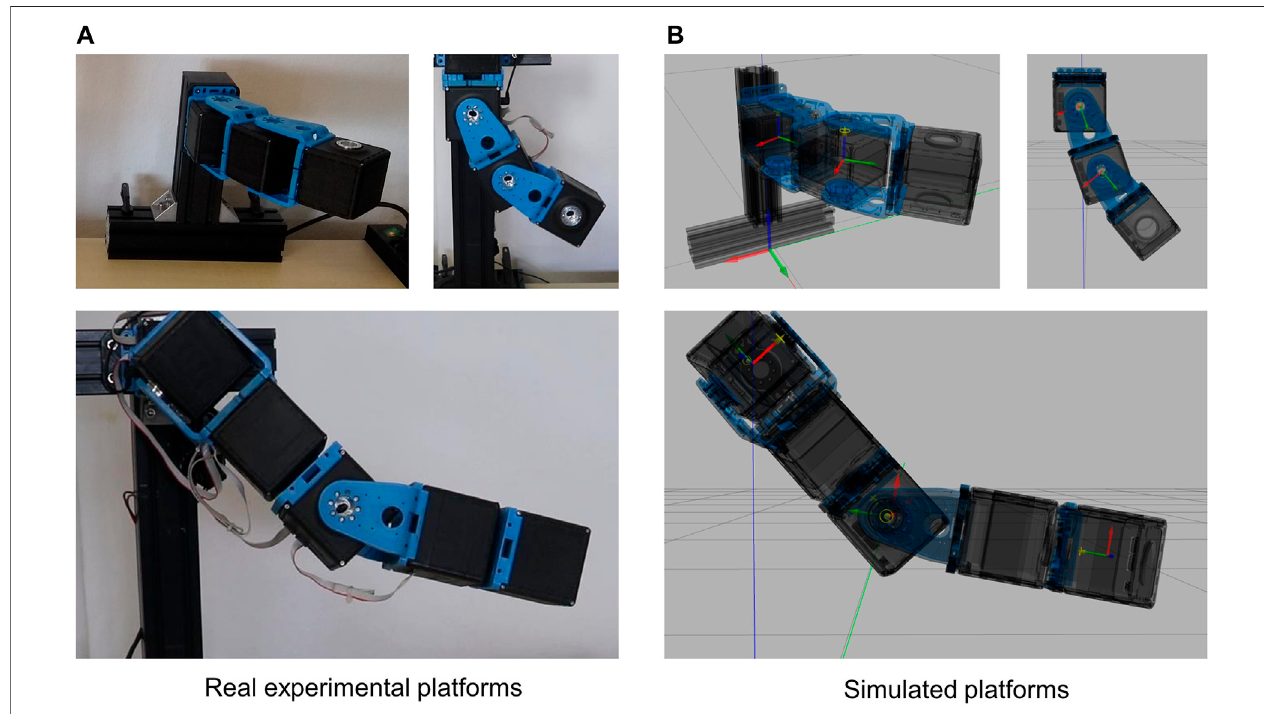
FIGURE 10 | Structures used for the validation of the proposed ROS-Gazebo modules. The top fi gures in panel (A) and panel (B) show the 2-DOFs system in horizontal (left-hand side) and vertical (right-hand side) con fi guration, while the bottom fi gures depict the 5-DOFs experimental and simulated arm, respectively.